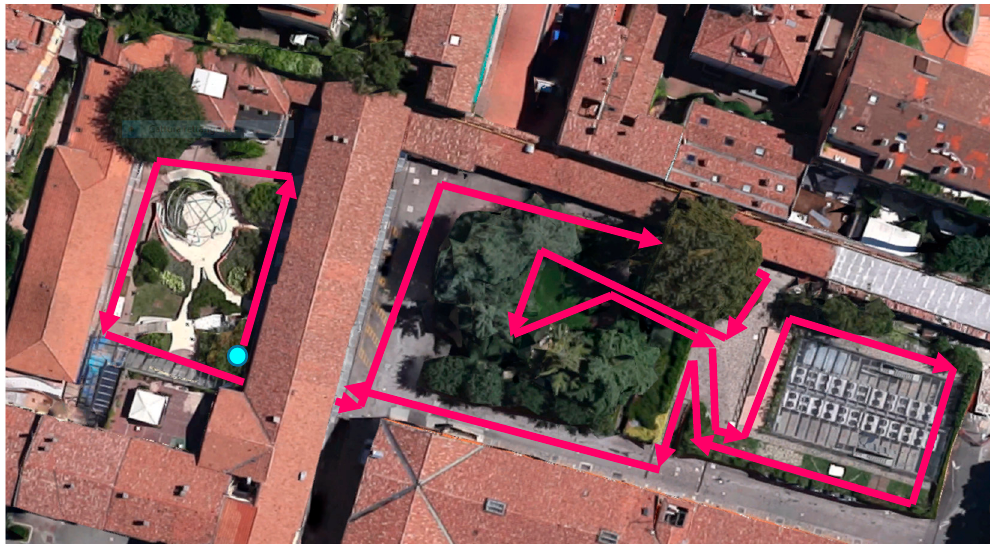
Figure 3. The PMD circuit developed on the CRA service premises (the individual components are listed in Appendix B).